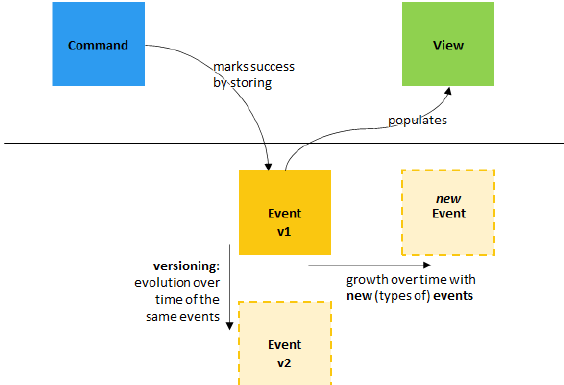
Figure 2 . Event versioning in an Event Sourced